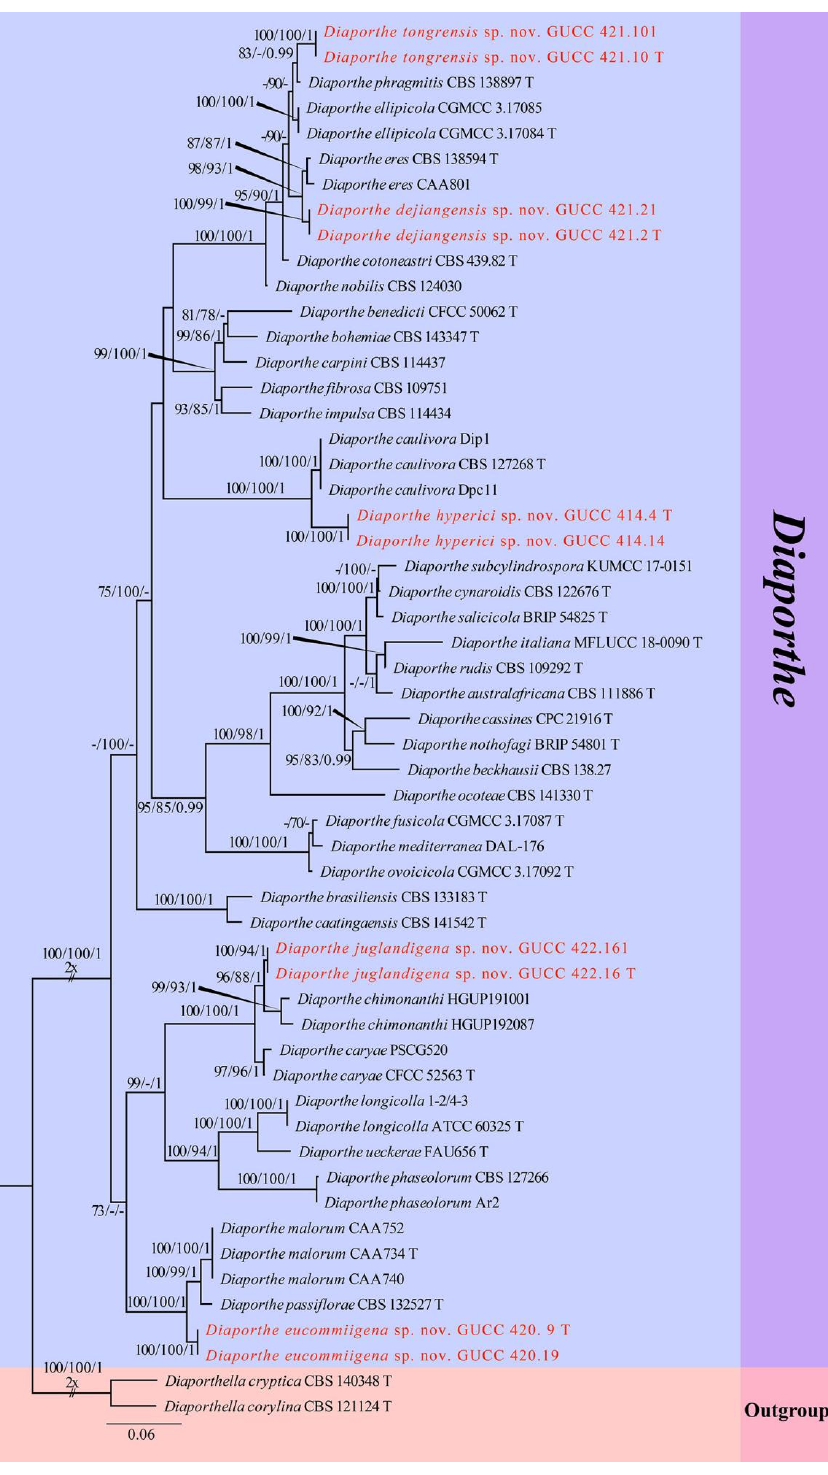
Figure 3. Phylogram generated from RAxML analysis of a concatenated ITS- tef1 - tub2 sequence dataset to represent the phylogenetic relationships of taxa in Diaporthe . The tree was rooted with Diaporthella corylina (CBS 121124, ex-type strain) and Di. cryptica (CBS 140348, ex-neotype strain). Bootstrap support values for ML and MP equal to or greater than 70% and Bayesian posterior probabilities equal to or higher than 0.95 PP are indicated above the nodes as ML/MP/PP. Support values lower than 70% ML/MP and 0.95 PP are indicated by a hyphen (-). The newly generated sequences are indicated in